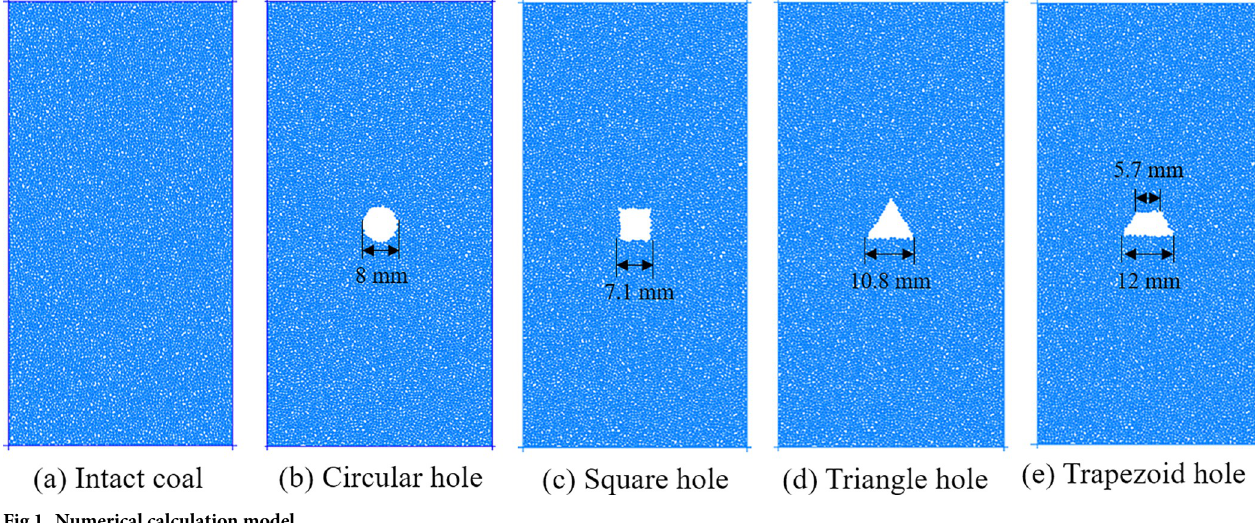
Fig 1. Numerical calculation